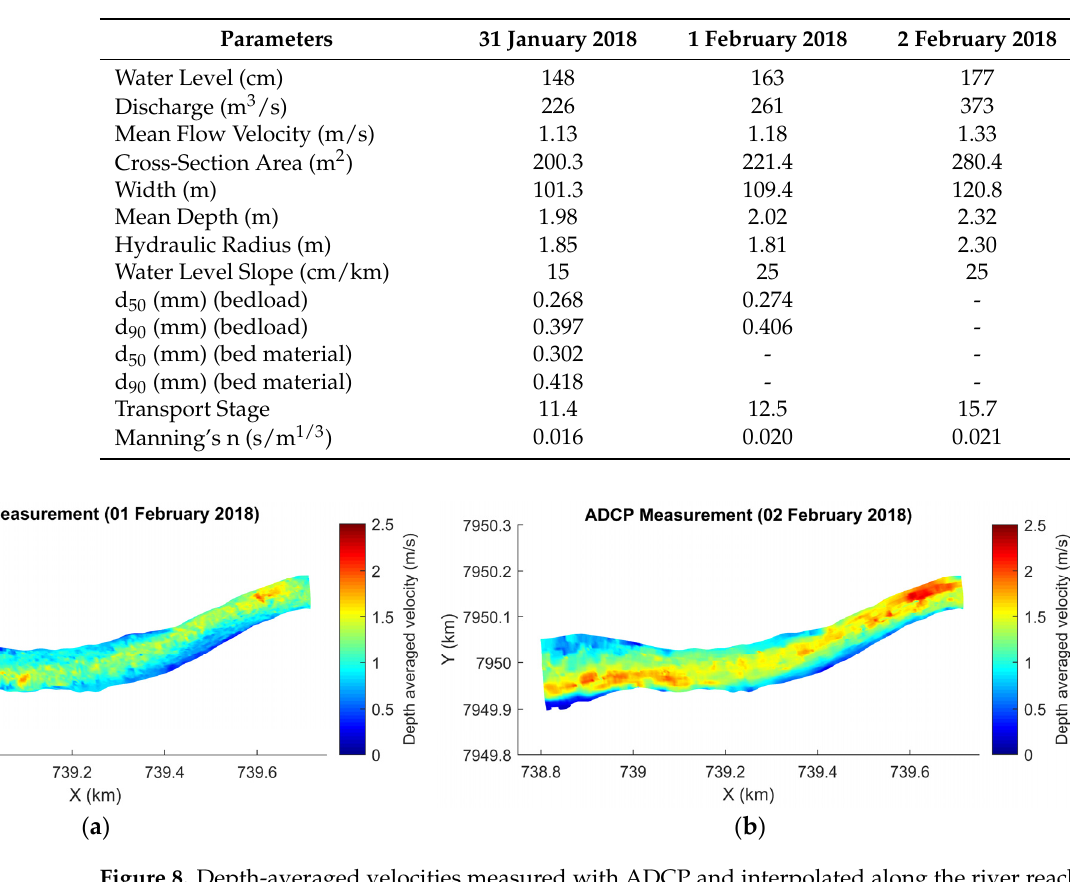
Figure 8. Depth-averaged velocities measured with ADCP and interpolated along the river reach. ( a ) 1 February 2018; ( b ) 2 February 2018. Table 3. Measured and estimated hydraulic parameters at Taquari River, cross-section P1. Figure 9a illustrates a DEM (1 February 2018) of the region where the modified ISS- DOTv2 method was applied. By the plot difference of the two DEMs (2 February